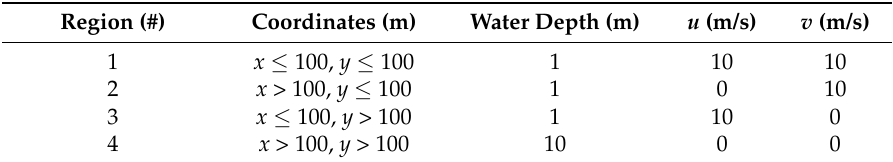
Table 3. Initial conditions for the 2D Riemann